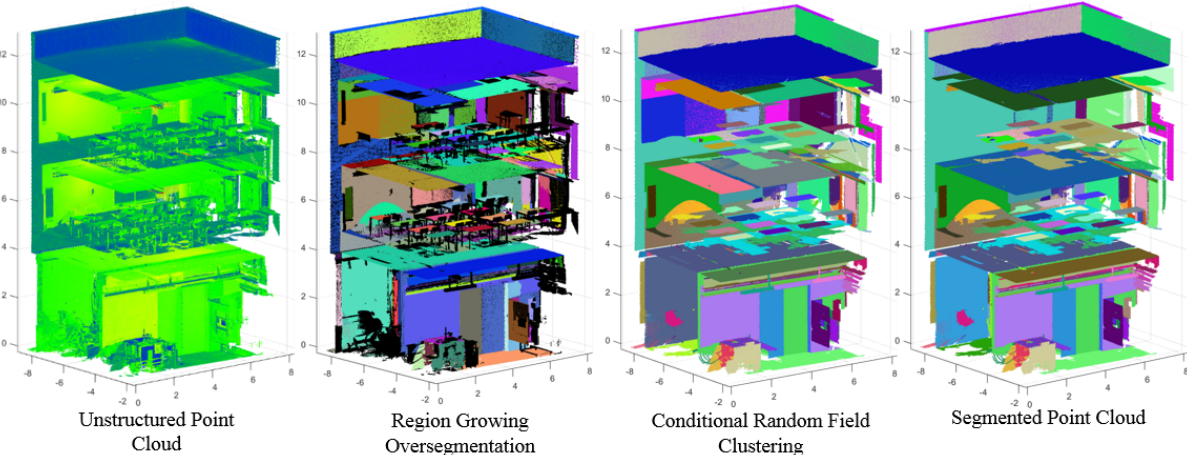
Figure 1 . Overview workflow and intermediate results. Initial point cloud (a), oversegmented clusters with non-valid clusters in black (b), graph representation of clusters (c) and the final grouped clusters (d).